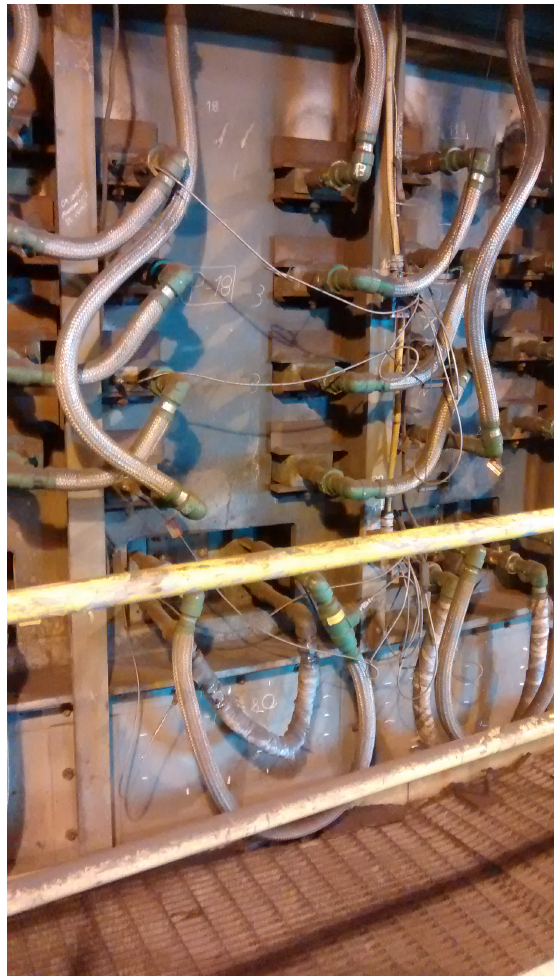
Figure 3. Photography of CMSA furnace outside wall with its